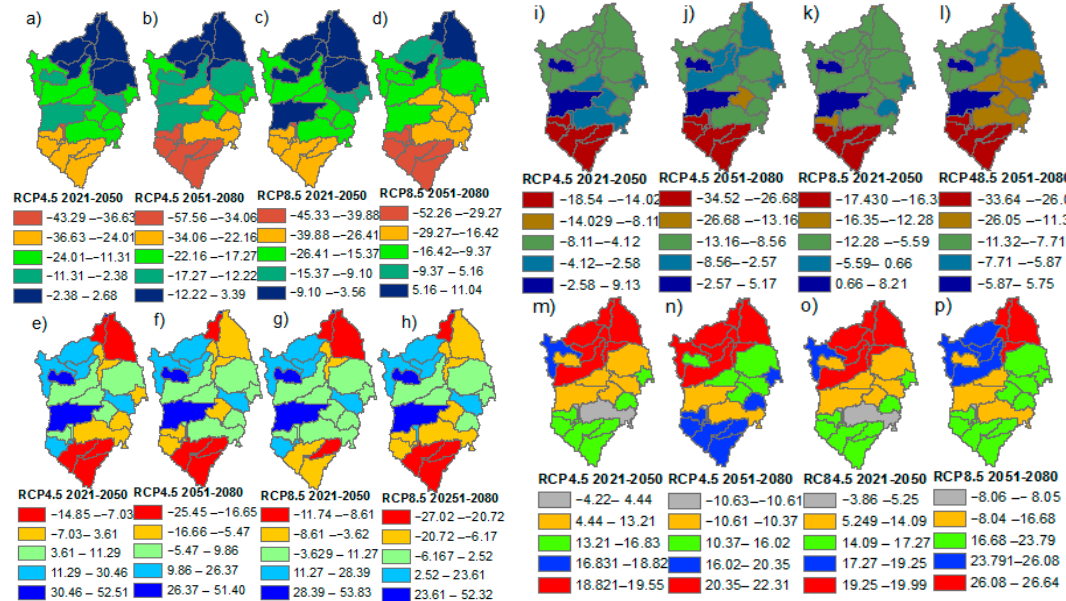
Figure 13. Spatial patterns of the changes in surface runoff ( a , b , c and d ), groundwater ( e , f , g and h ), water yield ( i , j , k and l ) and PET ( m , n , o and p ) under the combined LULCC and climate change.